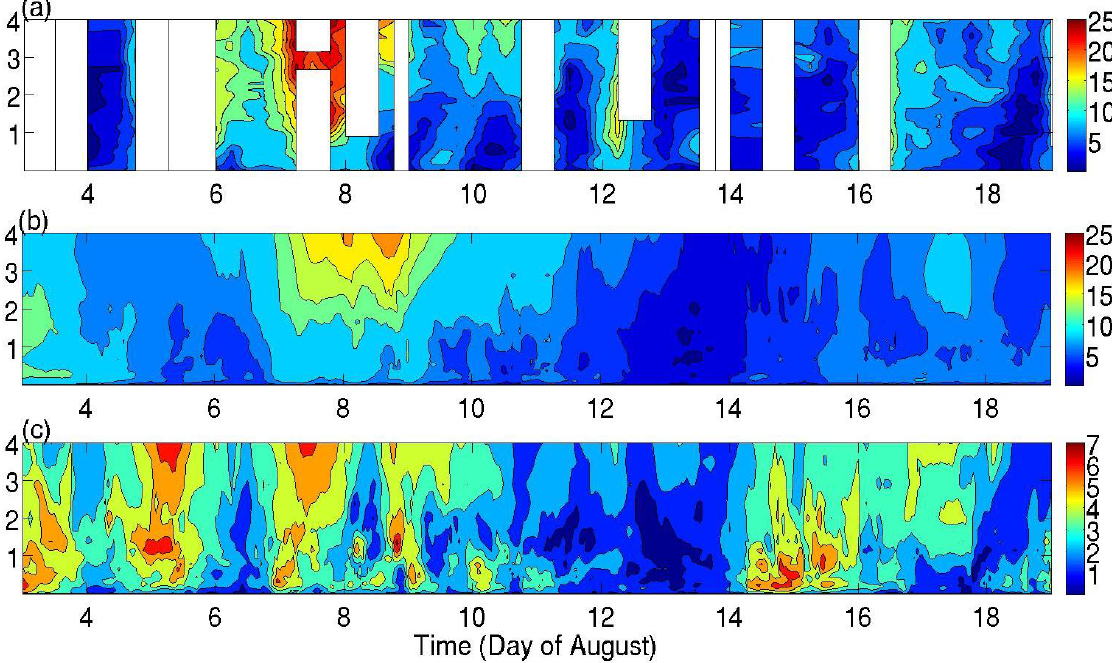
Figure 5. Time-height cross-sections of atmospheric wind speed (ms −1 ) showing ( a ) observations, the modeled ( b ) ensemble average and ( c ) model ensemble standard deviation. Model ensemble statistics are based on hourly model output while observations were nominally taken six-hourly. White fields in ( a ) are due to missing